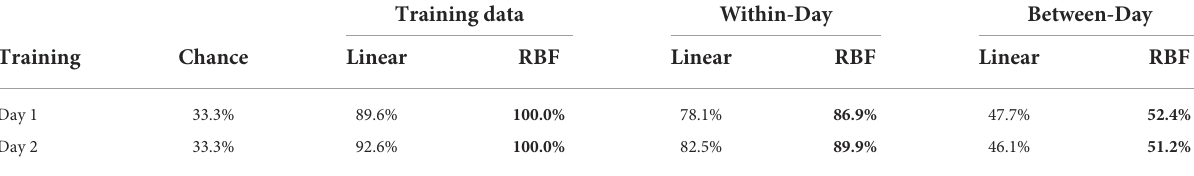
TABLE 3 Linear vs. nonlinear model comparisons for one participant’s data to predict the number of